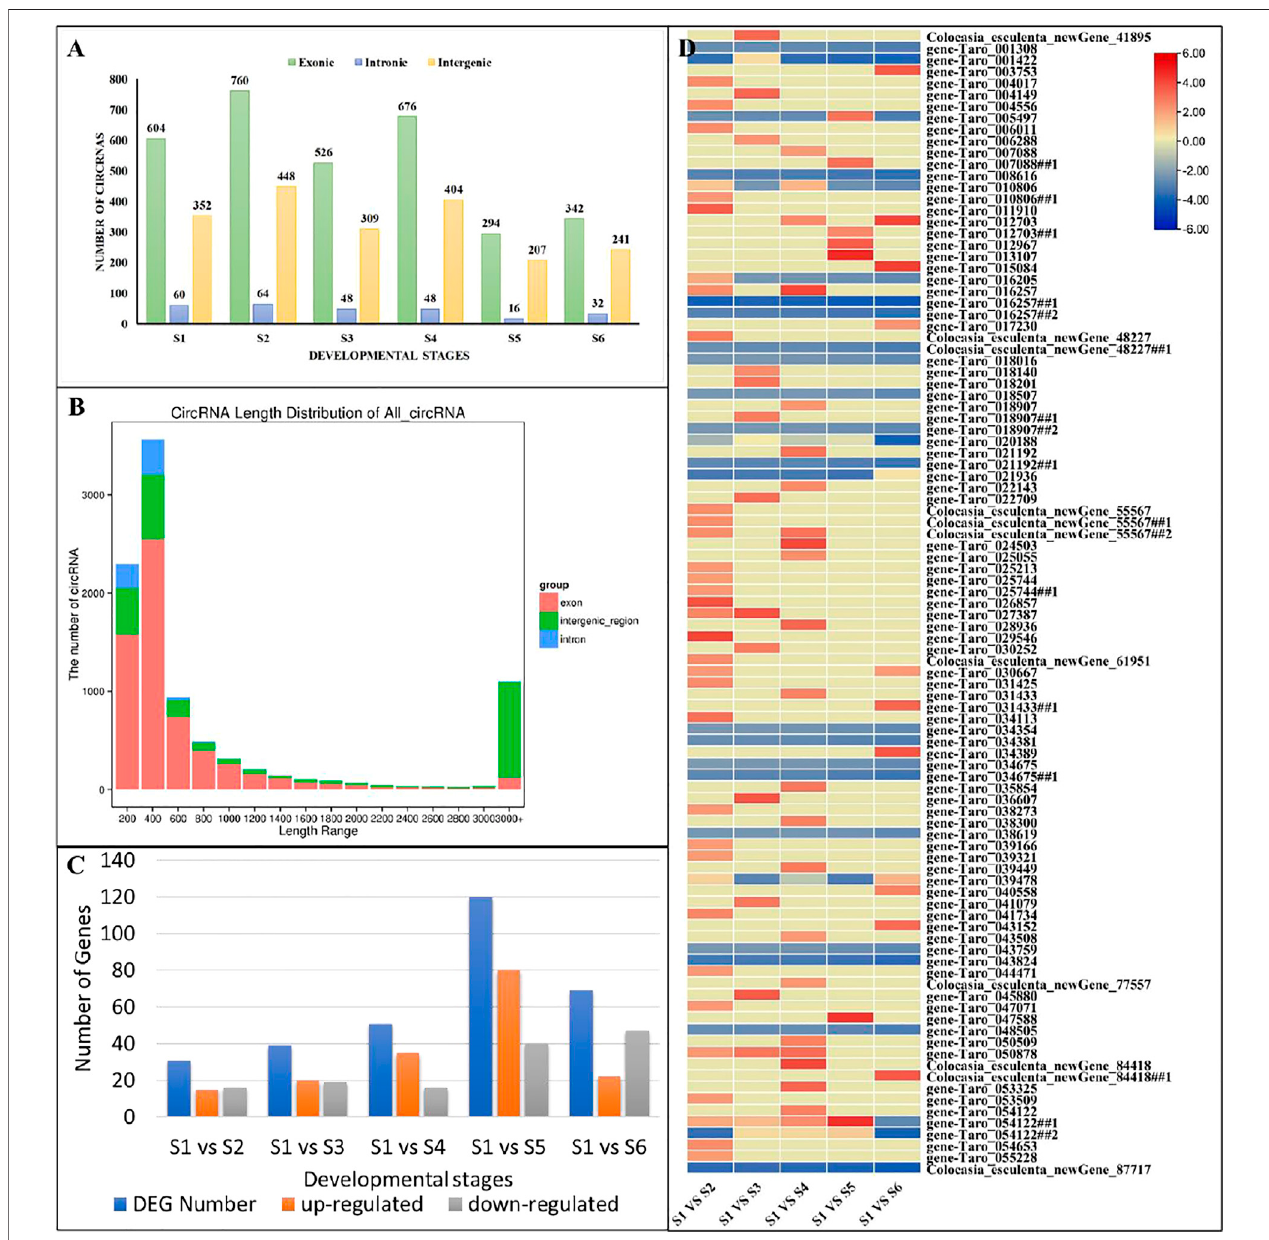
FIGURE5| CharacterizationofCircRNAs. (A) Distribution oftheidenti fi edCircRNAsaccrsoosgrowthstages. (B) LengthdistributionofCircRNAs. (C) Numbersof differentially expressed CircRNAs in pairwise comparisons of growth stages. (D) expression patterns of differentially expressed CircRNAs in pairwise comparisons of growth stages. Genes with the symbols ##, represents spliced